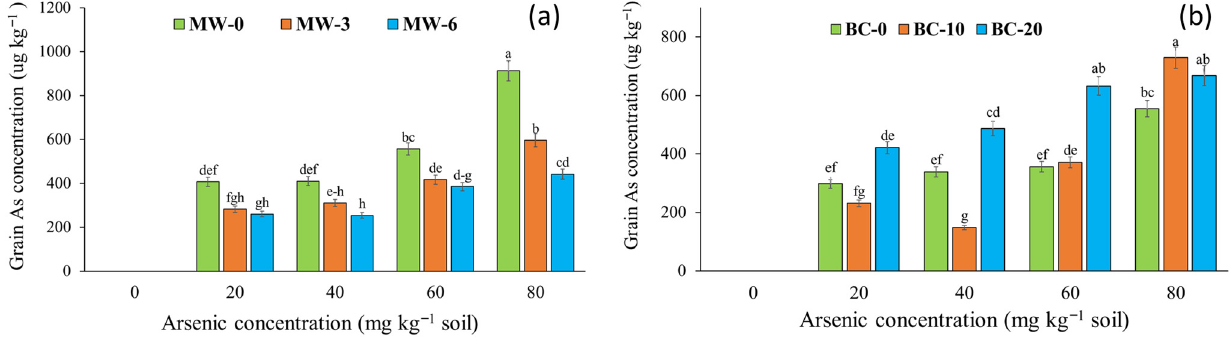
Figure 7. Effect of soil arsenic (As) on grain As concentration in response to ( a ) microwave (MW) and ( b ) biochar (BC) treatments. Replicated mean values are shown in the bars with standard error. The different letter indicates the significant difference (LSD test at 5% level of significance) among the treatments.